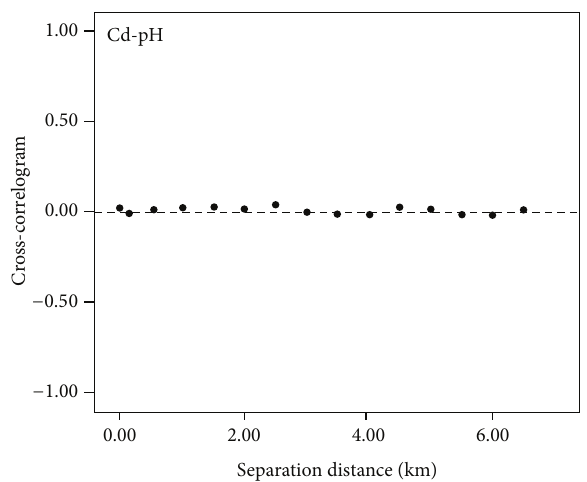
Figure 2: Cross-correlogram between Cd concentration and pH in